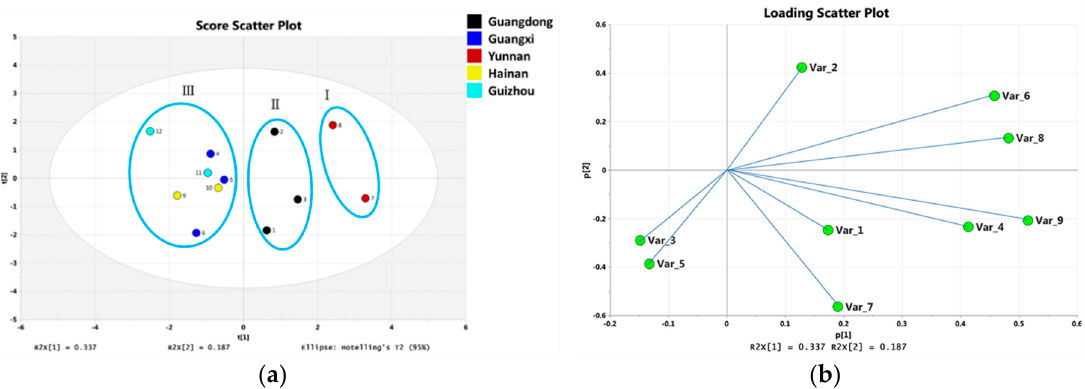
Figure 4. Principal component analysis (PCA)score plot ( a ) and loading plot ( b ) of the 12 batches of C. crassifolius samples on the basis of the relative peak areas of 9 diterpenoids.